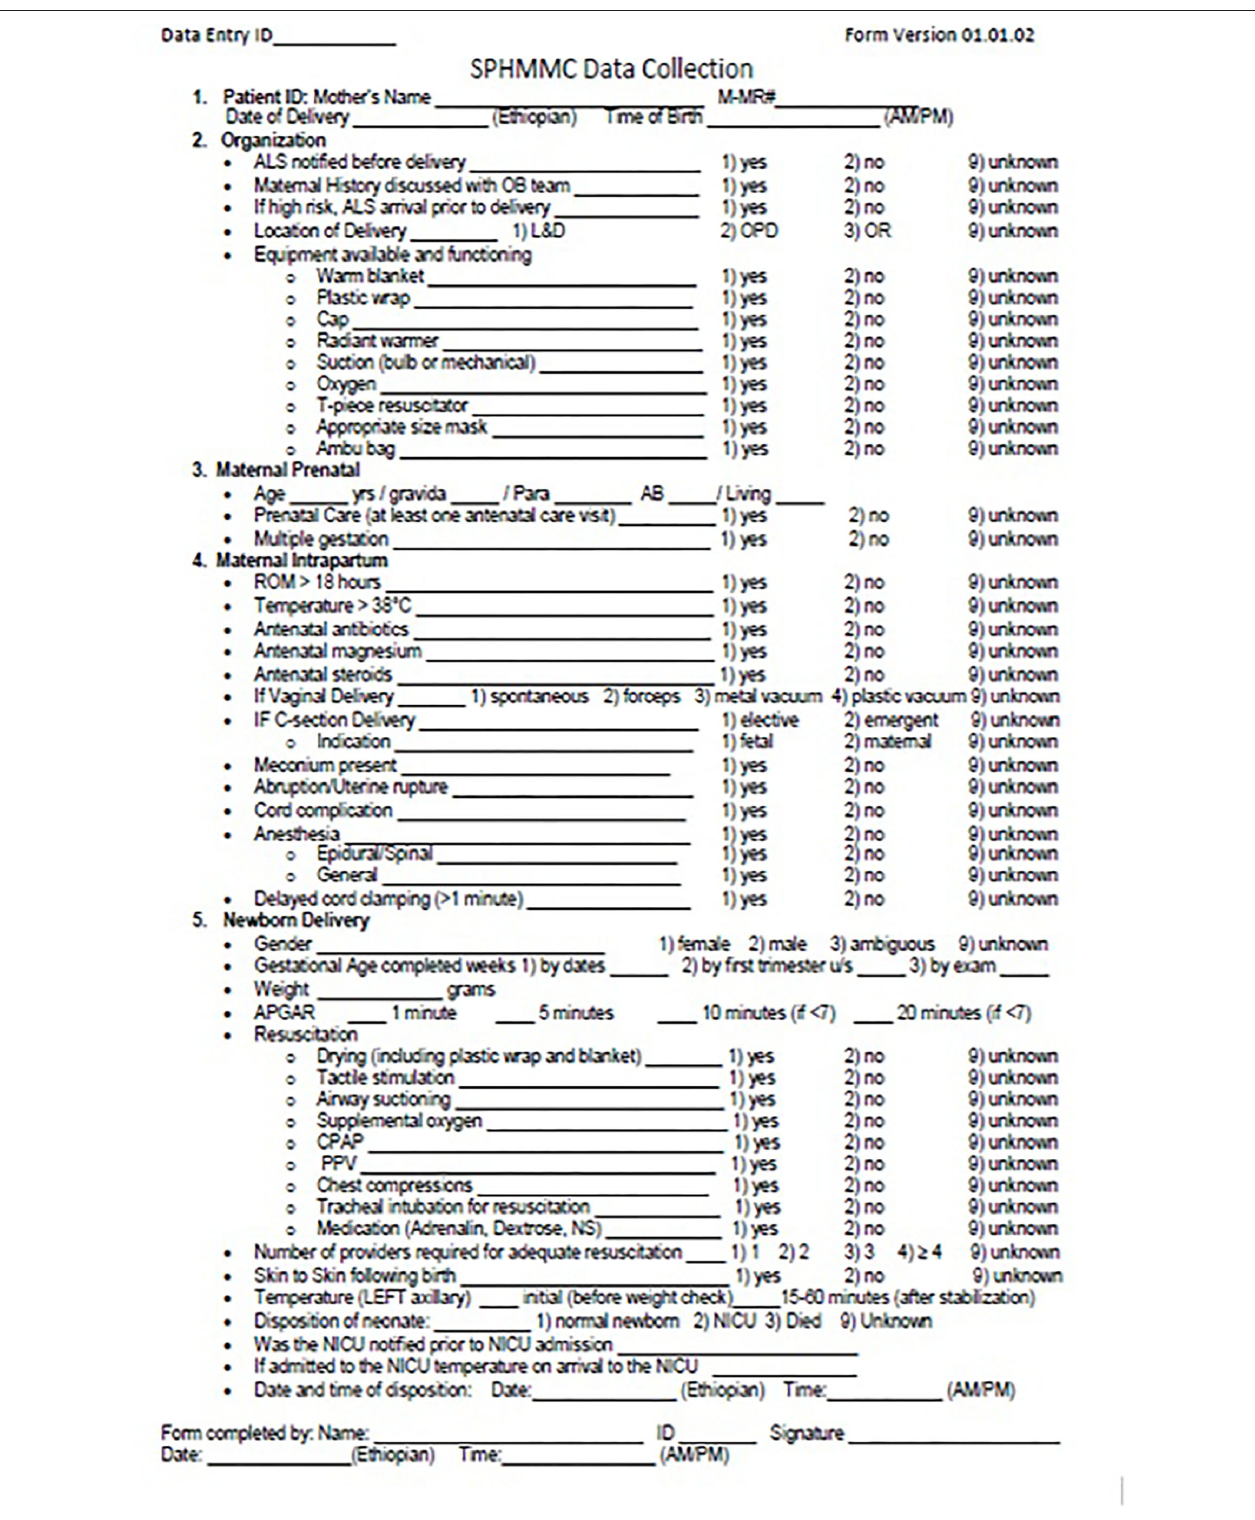
FIGURE 1 | Standardized data collection